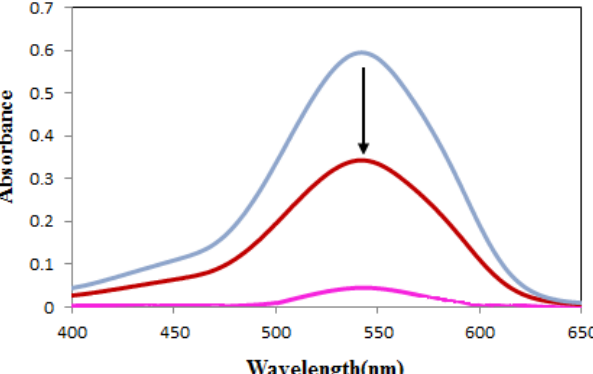
Fig. 12. The UV-Vis spectra of Cr - diphenyl carbaone complex